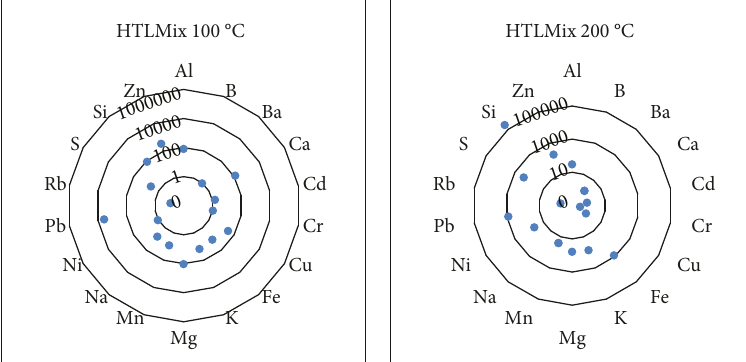
Figure 10: Concentration (in ppb) of the “ at risk ” elements in each sample reacted with the mixture of 0.01 M HCl and 0.003 M HNO 100 ° C temperature under 200bar pressure in Ti batch reactors after 770 hours (absence of data points re fl ects concentrations below the limits of detection).